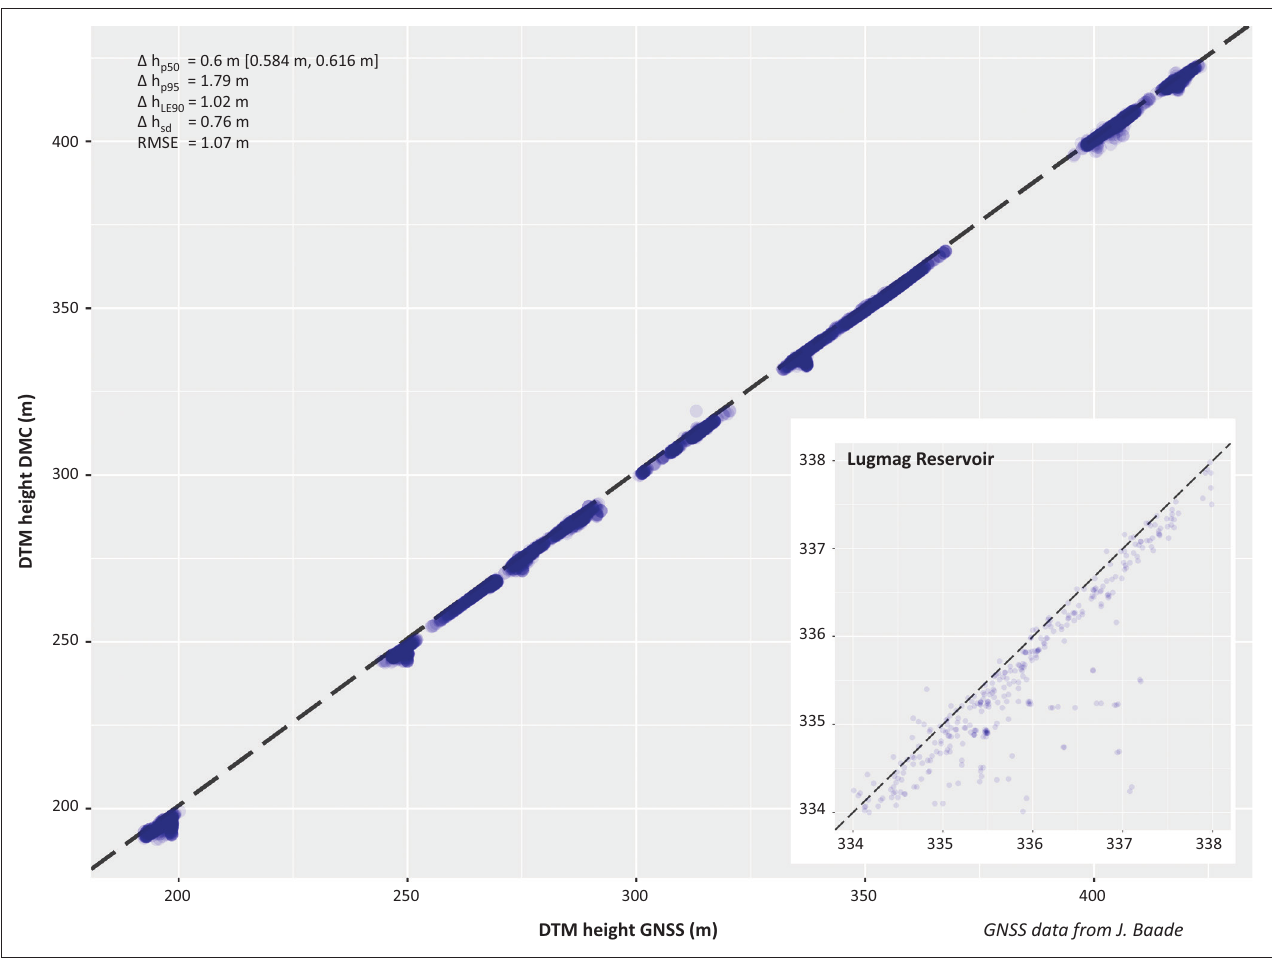
FIGURE 7: Validation of the modelled terrain (digital terrain model) elevation from stereoscopic aerial imagery with ground measurements for entire area and Lugmag Reservoir sub-site. More than ten study sites were included in the validation (see Figure 2 for the distribution of the